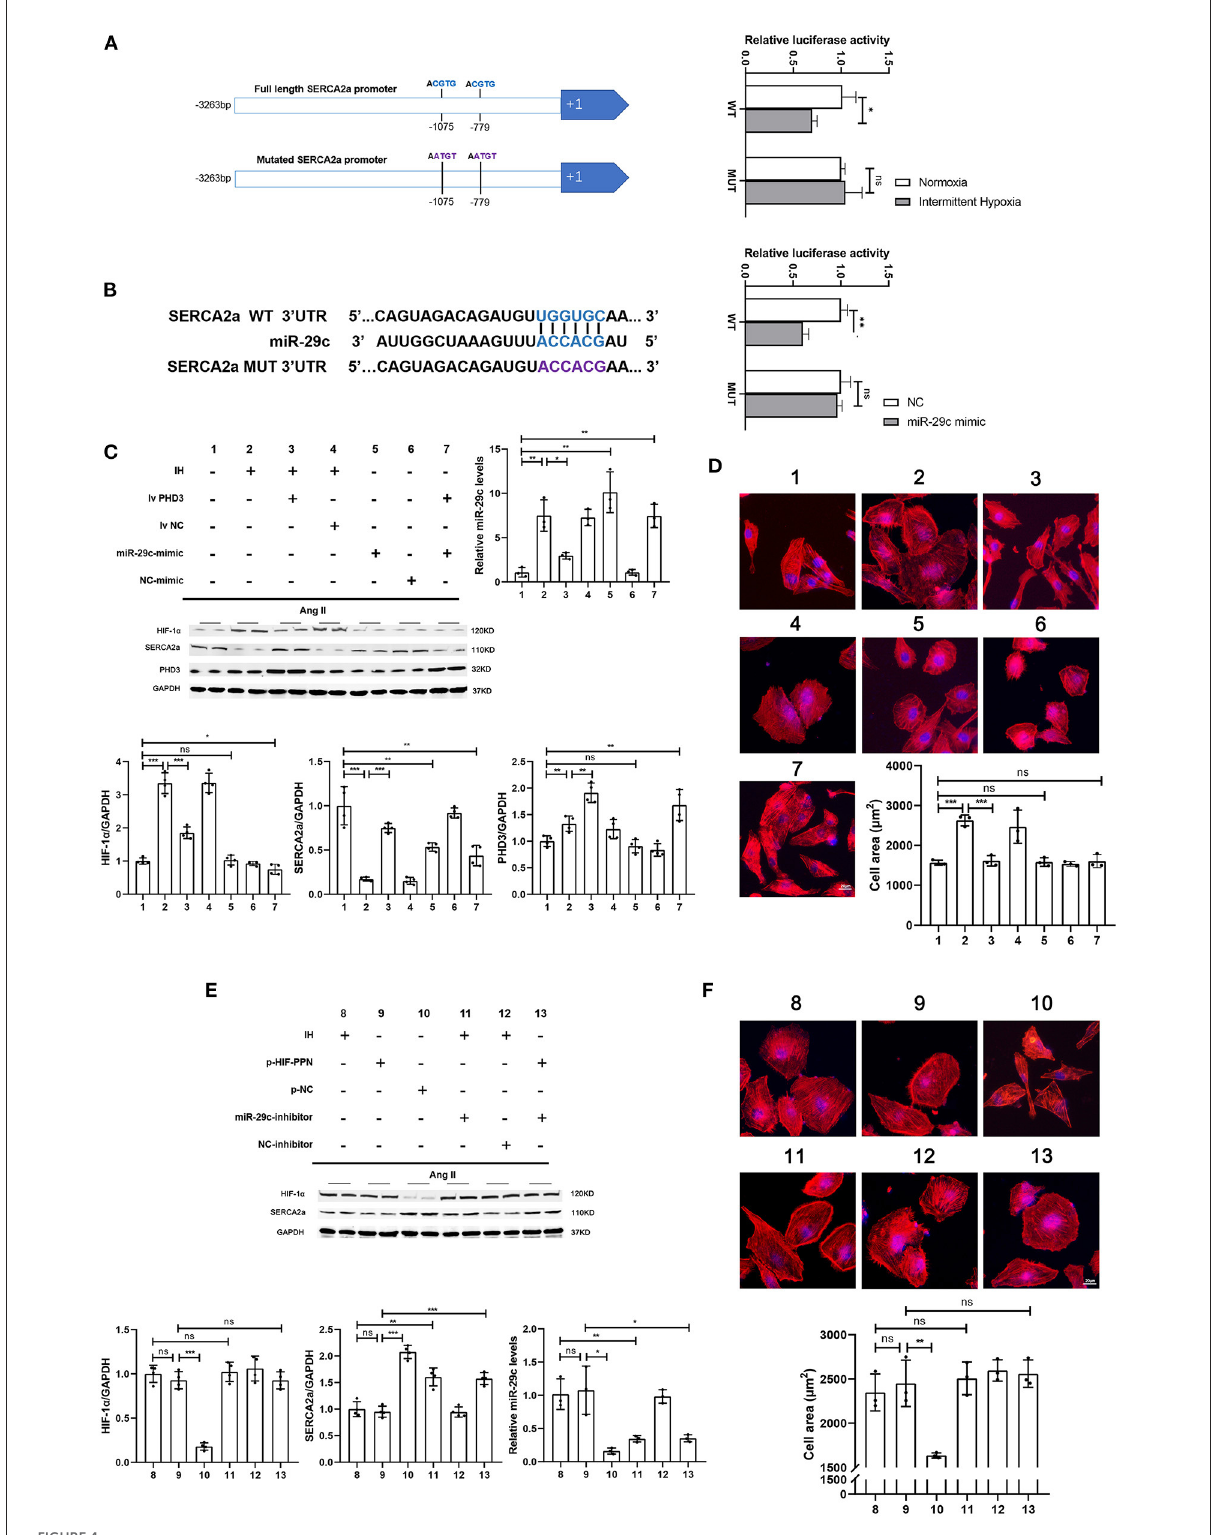
FIGURE4 HIF-1 α inhibits SERCA2a expression, promotes miR-29c expression and induces cardiomyocyte hypertrophy, while miR-29c only inhibits SERCA2a expression. (A) Two HIF-1 binding core sequences (HRE1 and HRE2) on the SERCA2 promoter were mutated to construct a SERCA2 promoter-luciferase reporter construct. HL-1 cells were transfected and then assayed for luciferase activity in normoxia and hypoxia. n = 3;